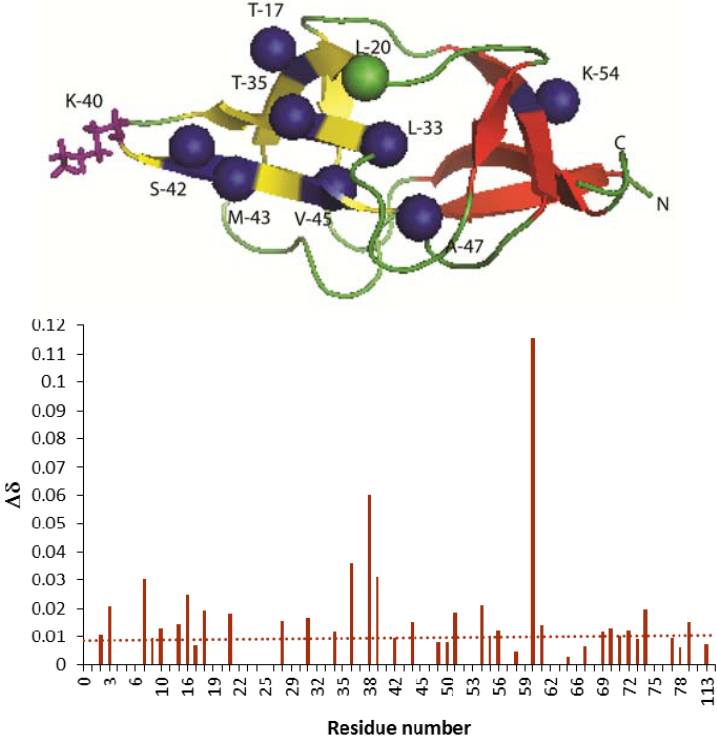
Figure 10. ( Top ) Structure of inner lipoyl domain from E. coli PDHc (PDB Id:1QJO). E2p- didomain residues, which disappeared on complexation with E1p were represented as spheres. Blue spheres represent the same amino acid in both the hybrid lipoyl domain and inner lipoyl domain. Green spheres correspond to different amino acids in the hybrid lipoyl domain (L-20 instead of M-21). Lipoyl lysine residue side chain in the type1 β turn is represented as a stick model. ( Bottom ) Chemical shift deviation of E2p-didomain after addition of 1 equivalent of E1p in the presence ThDP and